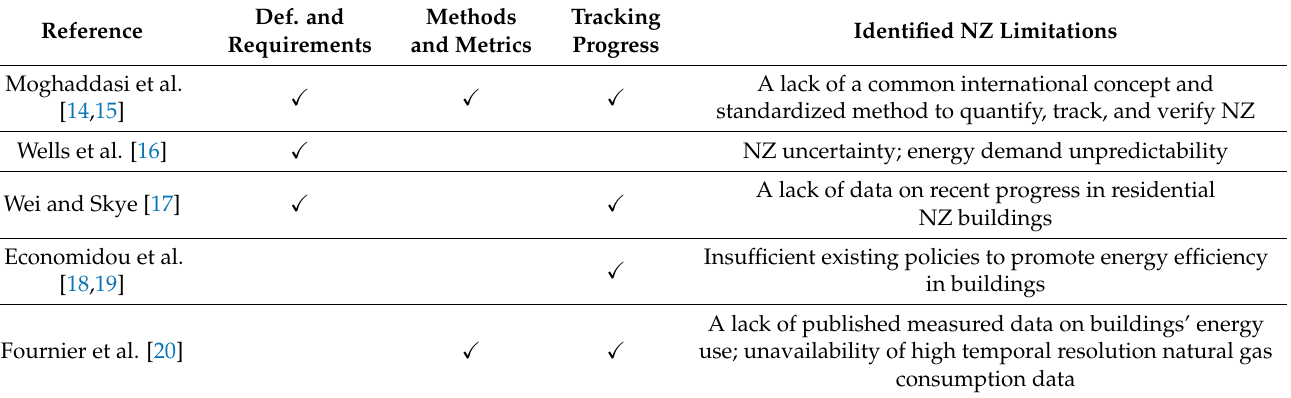
Table 2. Selected peer-review publications on NZ approaches and